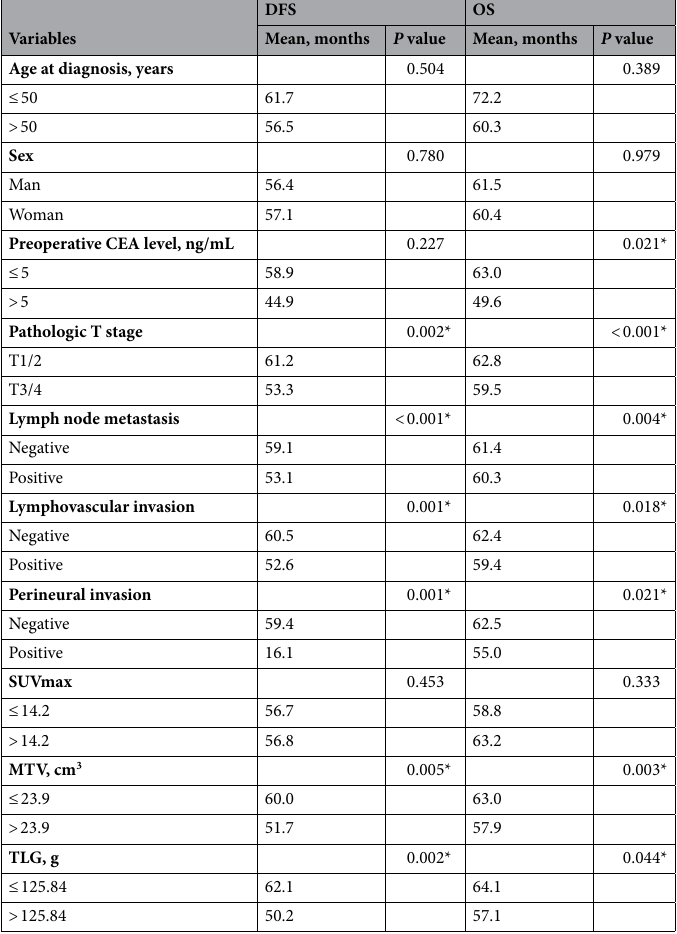
Table 2. Mean survival time and univariate analysis of disease-free survival and overall survival. CEA carcinoembryonic antigen, DFS disease-free survival, MTV metabolic tumour volume, OS overall survival,